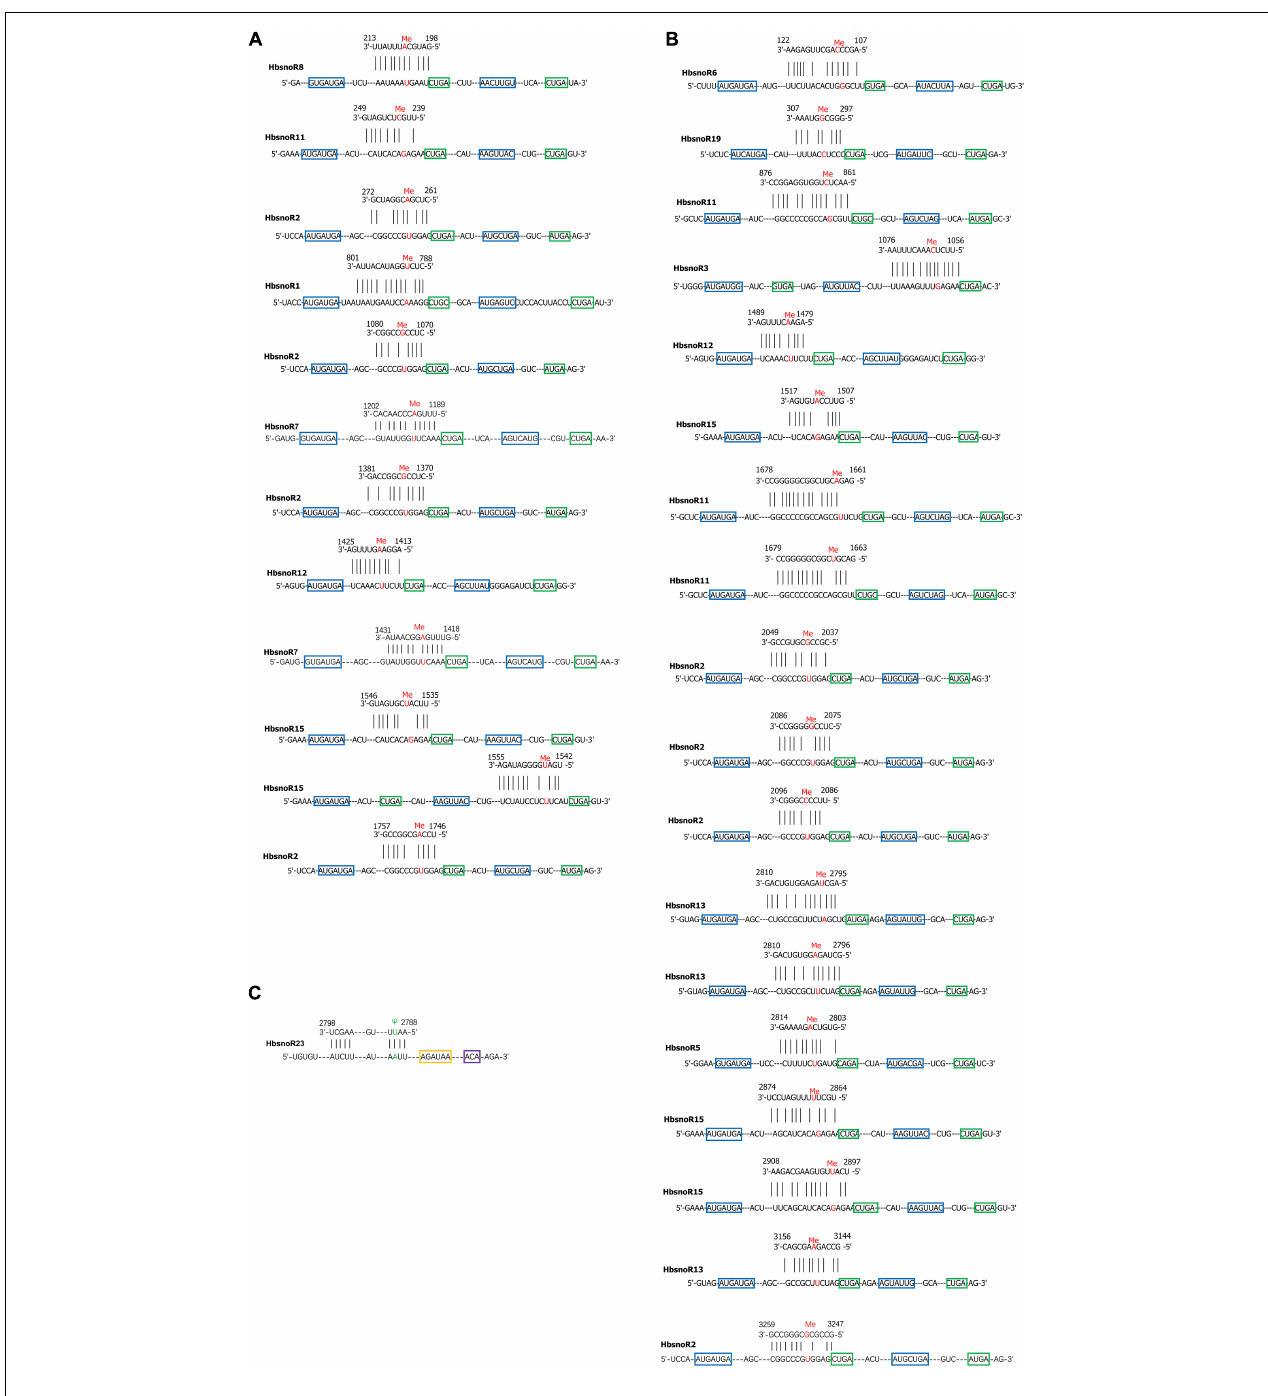
FIGURE 4 | (A) Predicted targeting sites of C/D subfamily small nucleolar RNA (snoRNAs) on (A) 18S and (B) 28S rRNA. The nucleotides under 2 (cid:48) - O -methylation were indicated in red color. The C box was shown in blue, while the D box was in green. (C) Predicted targeting sites of H/ACA subfamily snoRNAs on 28S rRNA, the nucleotide under pseudouridylation was indicated in green color. H box is shown in yellow and the ACA box in purple.